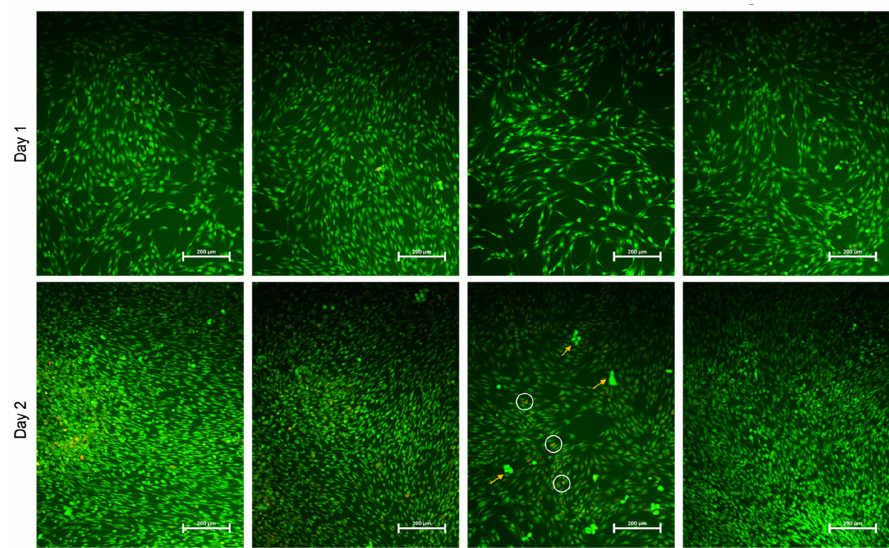
Figure 6. Representative fluorescence images (20 × ) of hBMSCs treated with the test medicaments, cells were stained with acridine orange/ethidium bromide AO/EtBr and micrographs were taken after 24 and 48 h. White circles on red dots indicate dead (necrotic) cells, yellow arrows point to con- densed green structures that indicate chromatin fragments and apoptotic bodies. [Ca(OH) 2 : Calcium hydroxide, AgNPs: Silver nanoparticles, TAP: Triple antibiotic paste].